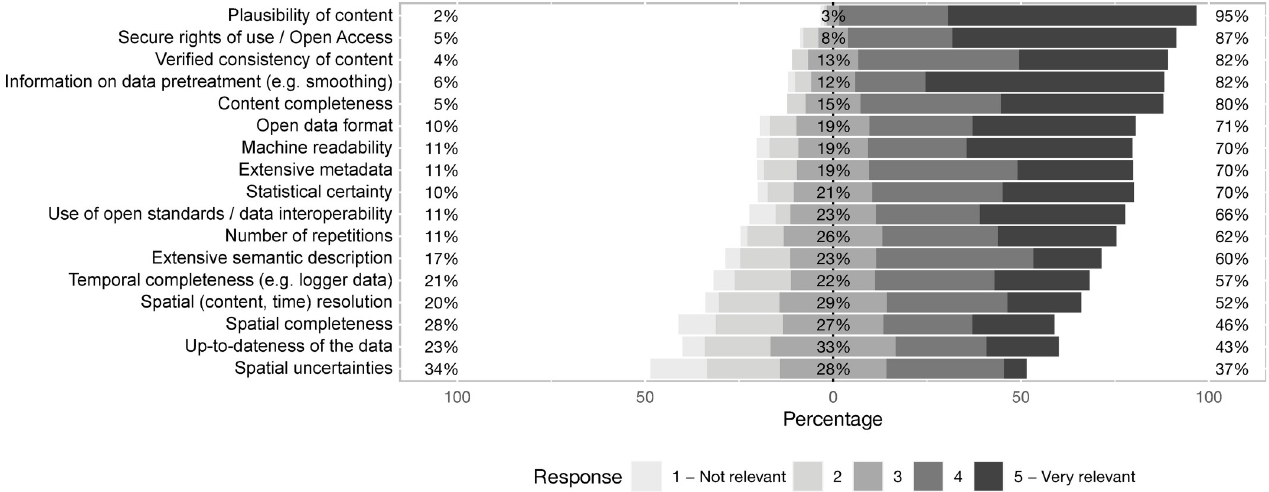
Fig 4. Important data quality aspects. Likert plot of data quality aspects that are important to data users (N = 67–126; Q29).